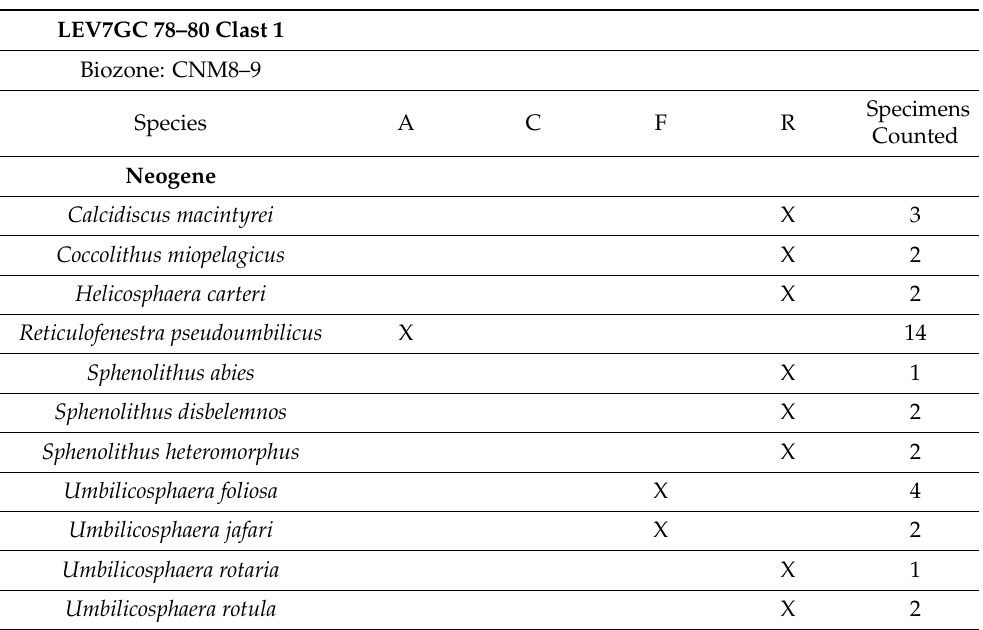
Table A34. Milano